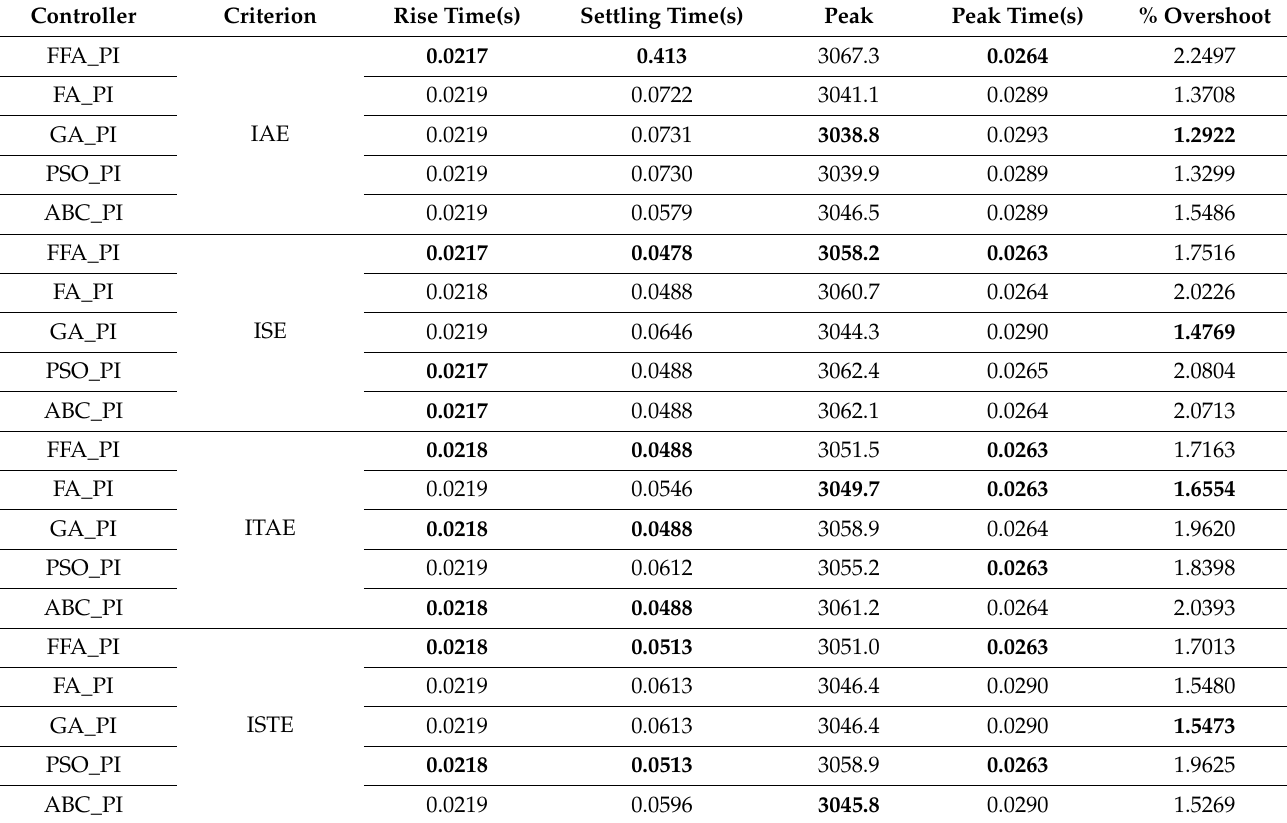
Table 8. Performance of the different